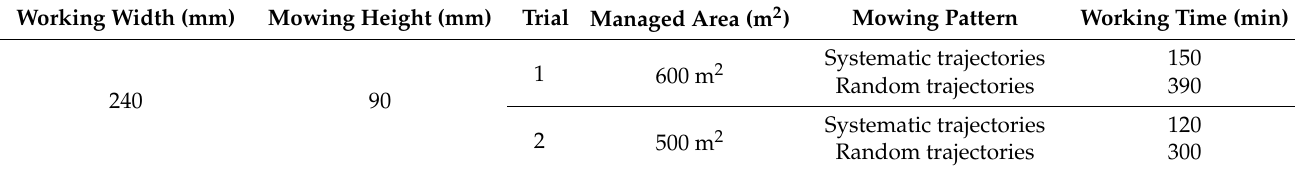
Table 1. Autonomous mowers’ operational characteristics for the two different trials. Working Width (mm) Mowing Height